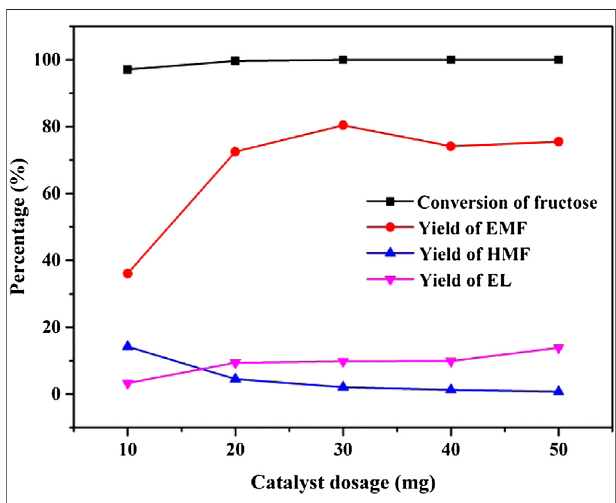
Frontiers in Chemistry |